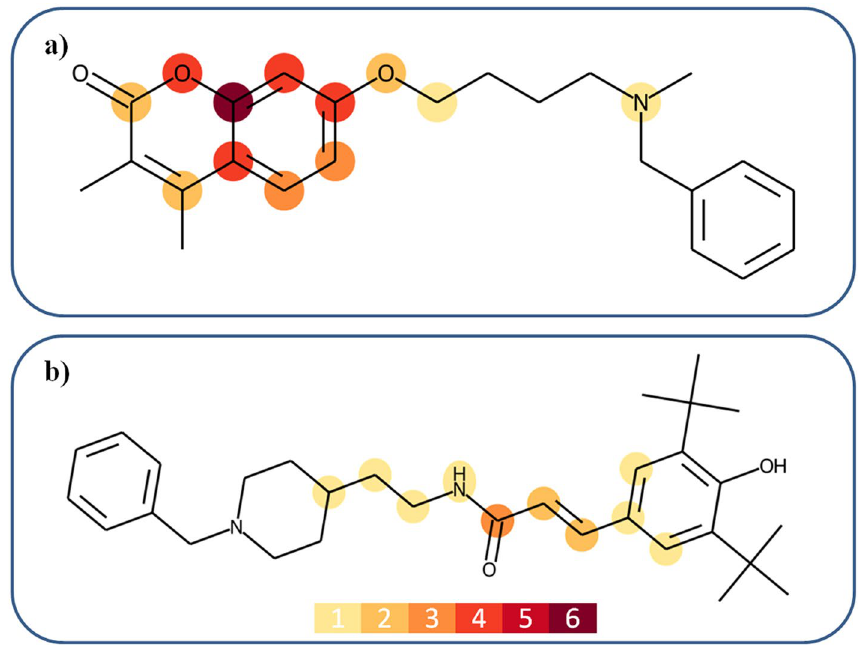
Figure 8. Feature mapping onto dual-target compounds from the second pair. Prioritized features are mapped onto MAOB-AChE DT-CPDs. The representation is according to Fig. 6. Atoms are color-coded according to the number of features containing them, as indicated by the insert at the bottom of ( b ). Accordingly, the color code ranges from light yellow for atoms contained in one feature to dark red for atoms contained in six features. Features determining the prediction of the compounds in ( a ) and ( b ) mostly delineate a coumarin substructure and an acrylamide linker fragment,